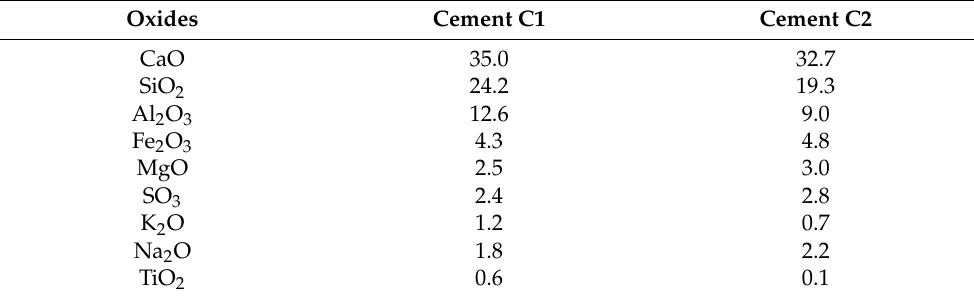
Table 2. Oxide components of cements, in percentage [31].